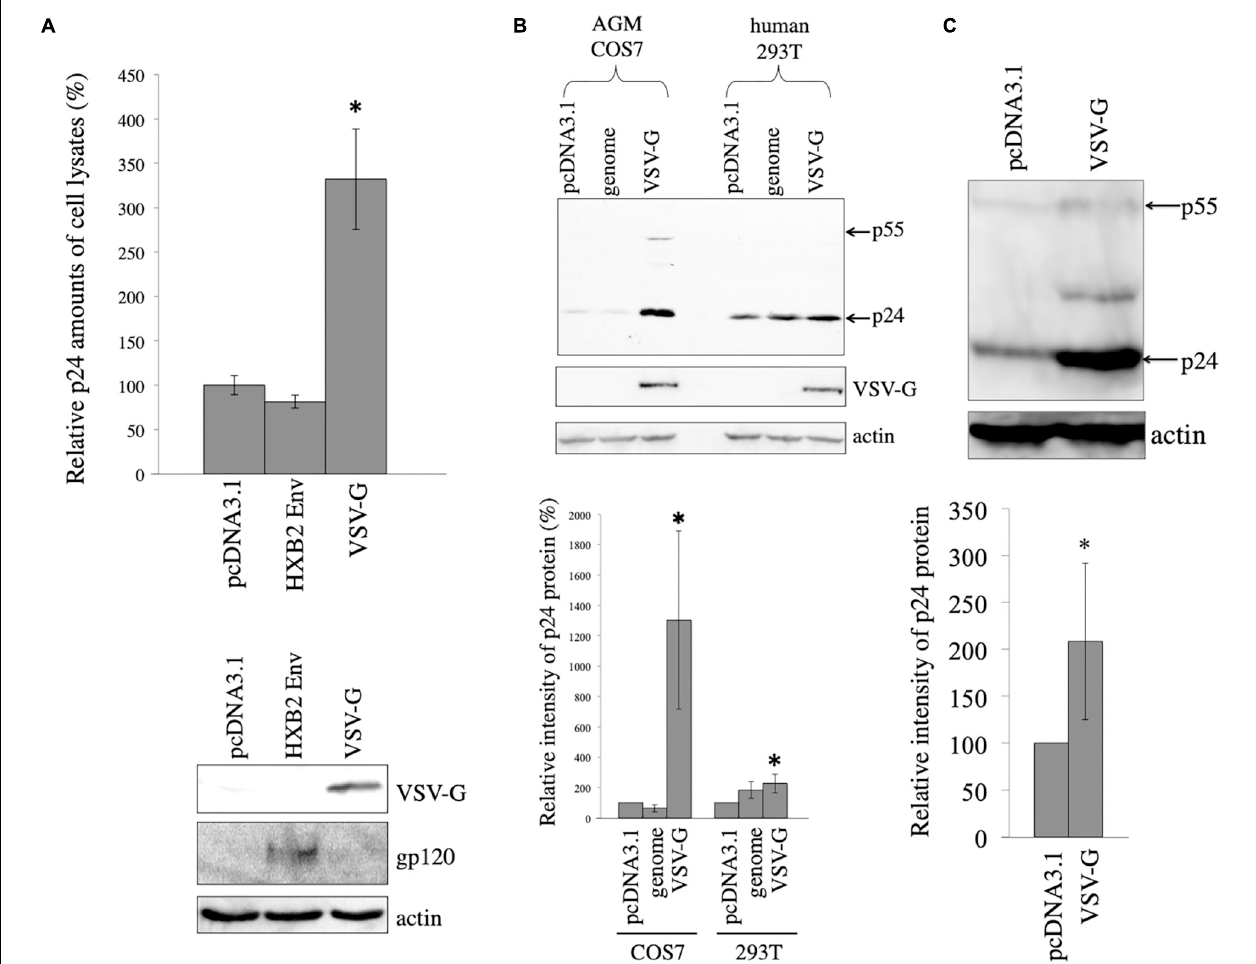
FIGURE 1 | VSV-G elevates HIV-1 Gag protein amount. (A) COS7 cells were transfected with the HIV-1 Gag-Pol expression plasmid together with pcDNA3.1, HIV-1 HXB2 Env, or VSV-G expression plasmid. HIV-1 p24 protein amounts in cell lysates were measured by ELISA. Relative values to the p24 amount in pcDNA3.1-transfected cells are indicated (upper panel). Asterisks show significant differences compared to pcDNA3.1. This experiment was repeated three times. Cell lysates from the transfected cells were analyzed by western immunoblotting using indicated antibodies (lower panel). (B) AGM COS7 and human 293T cells were transfected with the HIV-1 Gag-Pol expression plasmid together with pcDNA3.1, LacZ-encoding HIV-1 vector genome (genome), or VSV-G expression plasmid. Cell lysates from the transfected cells were analyzed by western immunoblotting (upper panel). HIV-1 Gag precursor (p55) and mature capsid (p24) were indicated by arrows. Intensities of HIV-1 p24 protein bands were measured by a densitometer. Relative values (%) to the intensities in the pcDNA3.1-transfected cells are shown (lower panel). This experiment was repeated three times. Asterisks show significant differences compared to pcDNA3.1. (C) African green monkey Vero cells were transfected with HIV-1 Gag-Pol expression plasmid together with pcDNA3.1 or VSV-G expression plasmid. Cell lysates prepared from the transfected cells were analyzed by western blotting (upper panel). Intensities of p24 bands were measured by a densitometer. Relative values to the intensities in the pcDNA3.1-transfected cells are shown (lower panel). This experiment was repeated three times. Asterisks show significant differences compared to